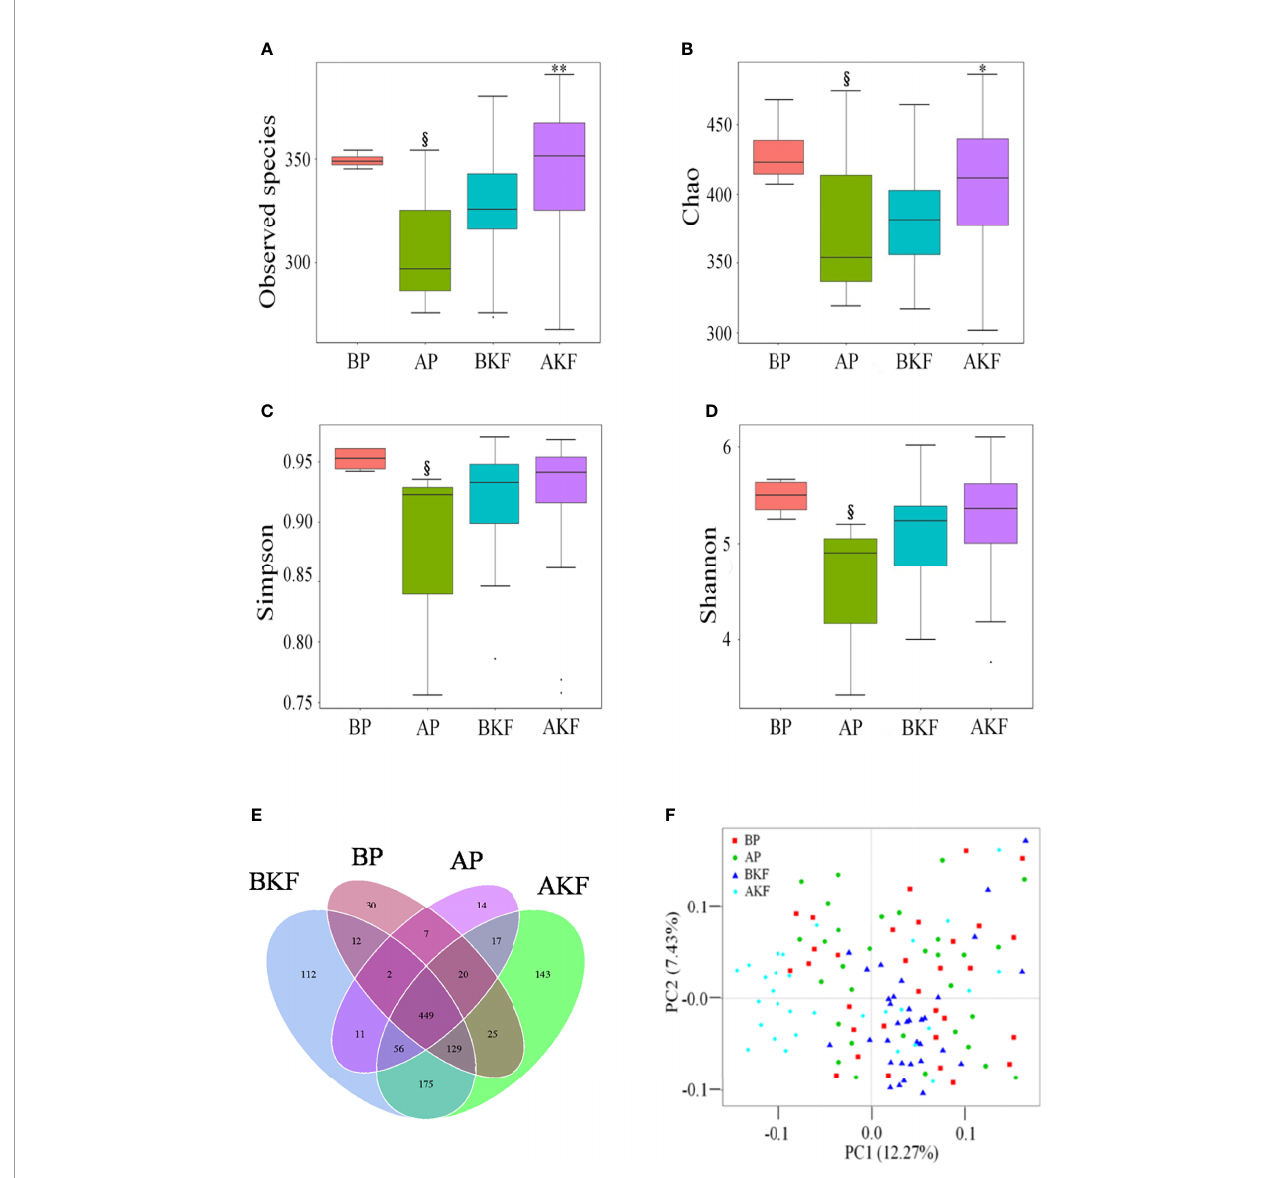
FIGURE 2 | KF treatment on gut microbiota richness and diversity. (A – D) a -diversity of the intestinal microbiota was measured by observed species (A) , Chao 1 index (B) , inverse Simpson index (C) , and Shannon index (D) . Venn diagram illustrated overlap of OTUs in the gut microbiota among the samples (E) . (F) b -diversity demonstrated that samples after treatment tender to cluster together and away from the samples before treatment. § p < 0.05 versus BP and * p < 0.05, ** p < 0.01 versus BKF. BP, before placebo; AP, after placebo; BKF, before konjaku fl our; AKF, after konjaku fl